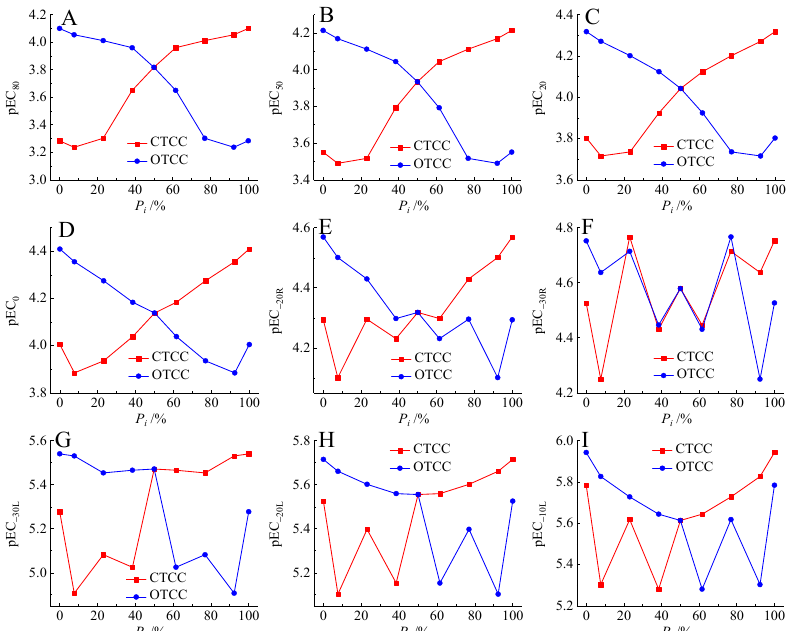
Figure 4. Relationship between mixture toxicities of pEC 80 ( A ), pEC 50 ( B ), pEC 20 ( C ), pEC 0 ( D ), pEC − 20R ( E ), pEC − 30R ( F ), pEC − 30L ( G ), pEC − 20L ( H ), pEC − 10L ( I ) and component molarity proportion ( P i )